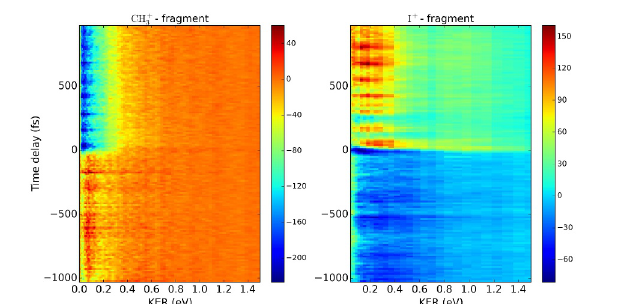
Fig 1. Time-dependent kinetic energy release maps of the CH 3+ (a) and I + (b) obtained with a 17.1 eV XUV pump pulse and an IR probe pulse. A positive delay means that the IR pulse comes after the XUV